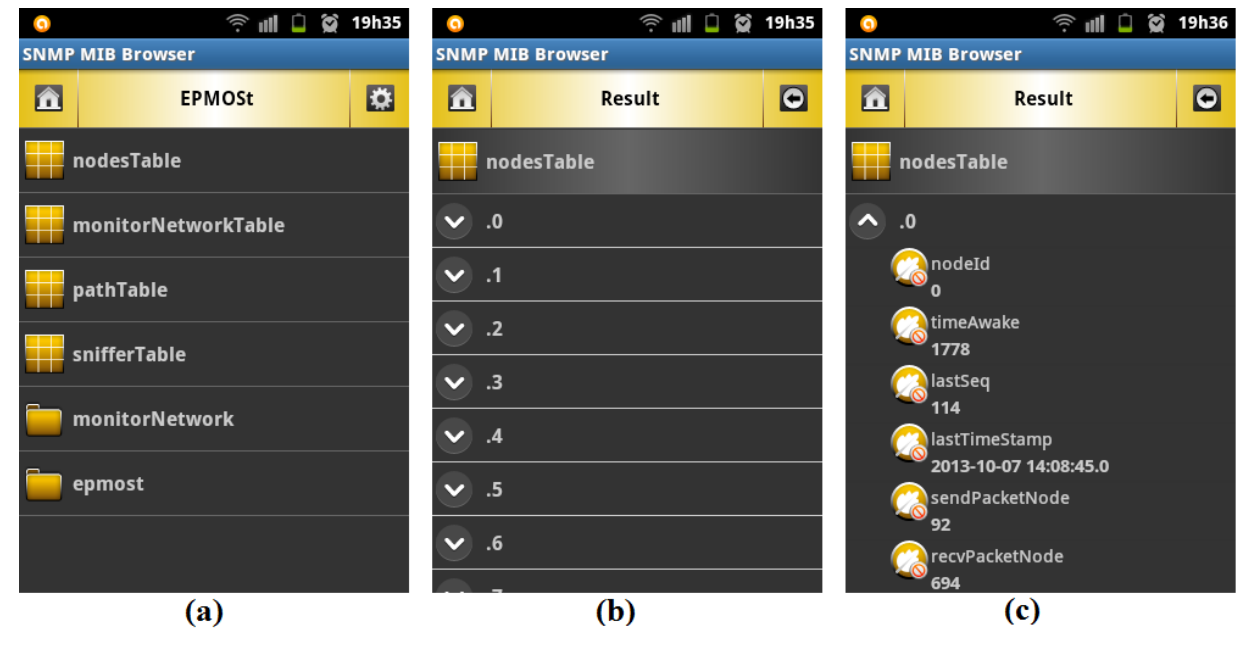
Figure 10. Operation of the ― SNMP MIB Browser Android Tool ‖: ( a ) Viewing the MIB of the EPMOSt. ( b ) Viewing the target nodes. ( c ) Viewing information about the node 0